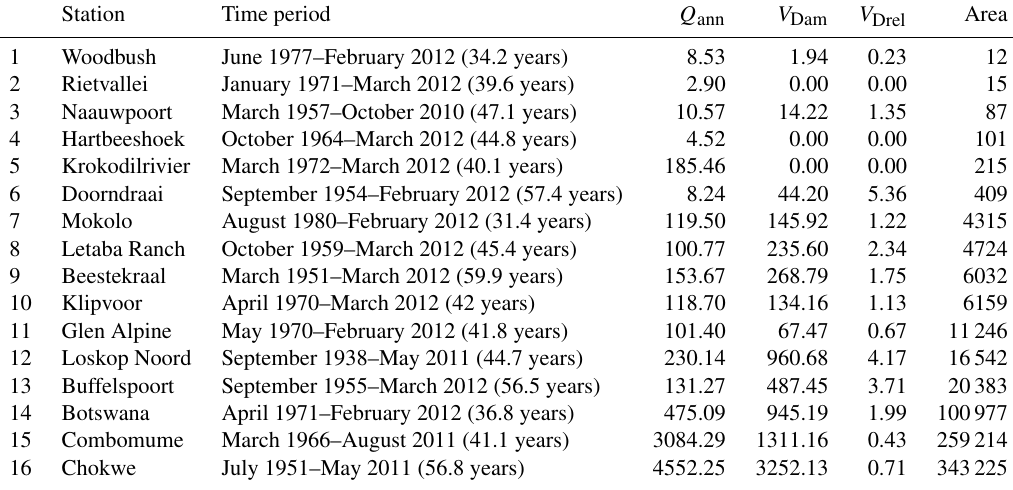
Table 1. Streamflow stations included in the analysis: observation period, average annual streamflow volume ( Q ann ) (in Mm 3 a − 1 ), dam capacity ( V Dam ) (in Mm 3 ), dam capacity relative to mean annual flow volume ( V Drel ), catchment area (area) (in km 2 ). Dam capacities are estimations based on available